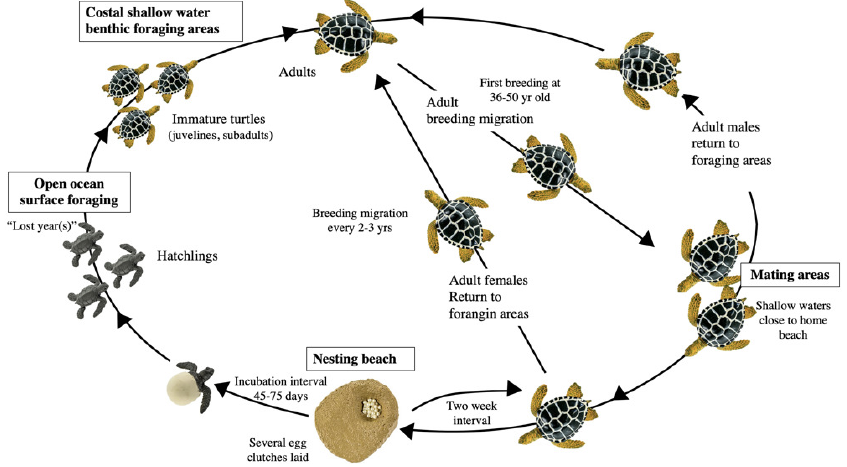
Fig. 1. Schematic diagram of the Chelonia mydas life